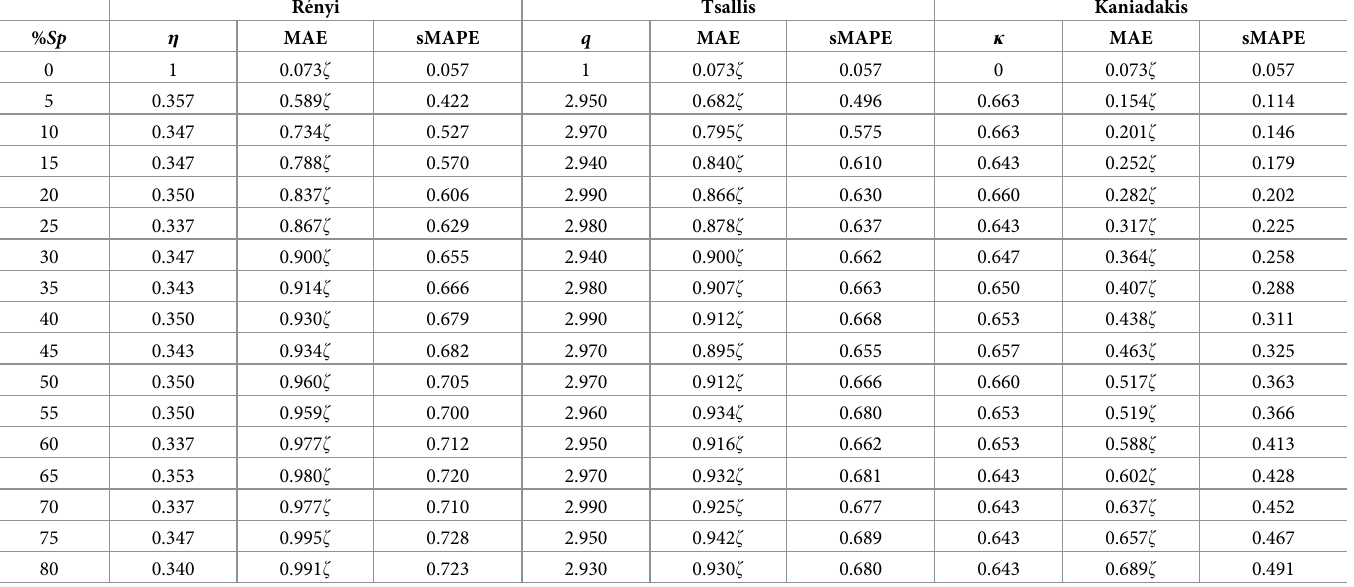
Table 1. Summary of smallest Mean Absolute Error (MAE) and symmetric Mean Absolute Percentage Error (sMAPE) values for objective functions based on Re´nyi, Tsallis and Kaniadakis frameworks. % Sp indicates the percentage of spikes, while z represents a normalization constant for the MAE to present this error metric best. The maximum MAE value is z = 4, 020.91, which happened in the numerical test with % Sp = 80 using the conventional objective